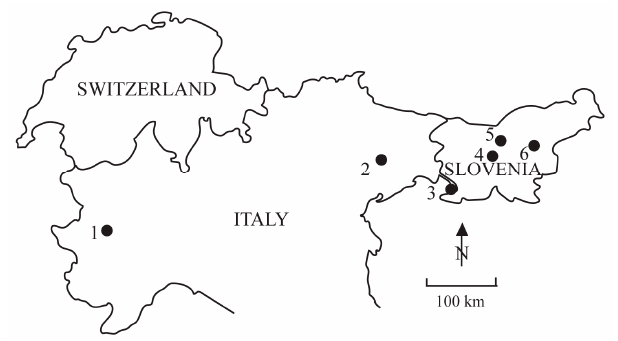
Figure 23. Map of Italy and Slovenia with the location of six white earthenware manufactories: 1 Torino (production start 1824), 2 Pordenone (1797), 3 Trieste (1776), 4 Ljubljana (1795), 5 Kamnik (1855), 6 Nemski dol (1817).